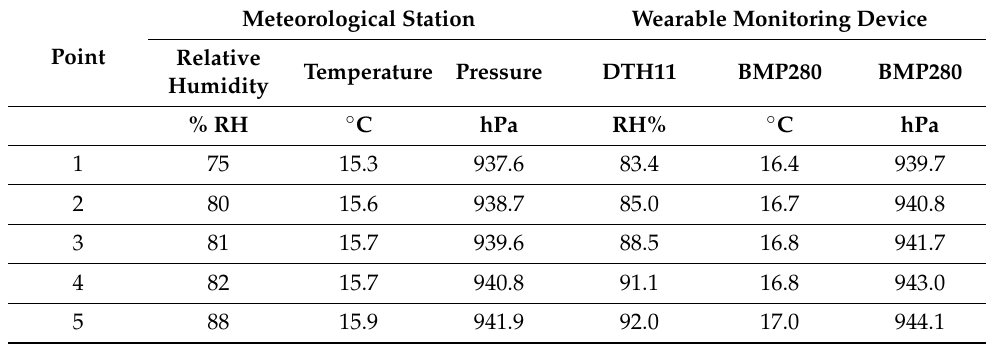
Table 1. Simple average of measured parameters in points 1 to